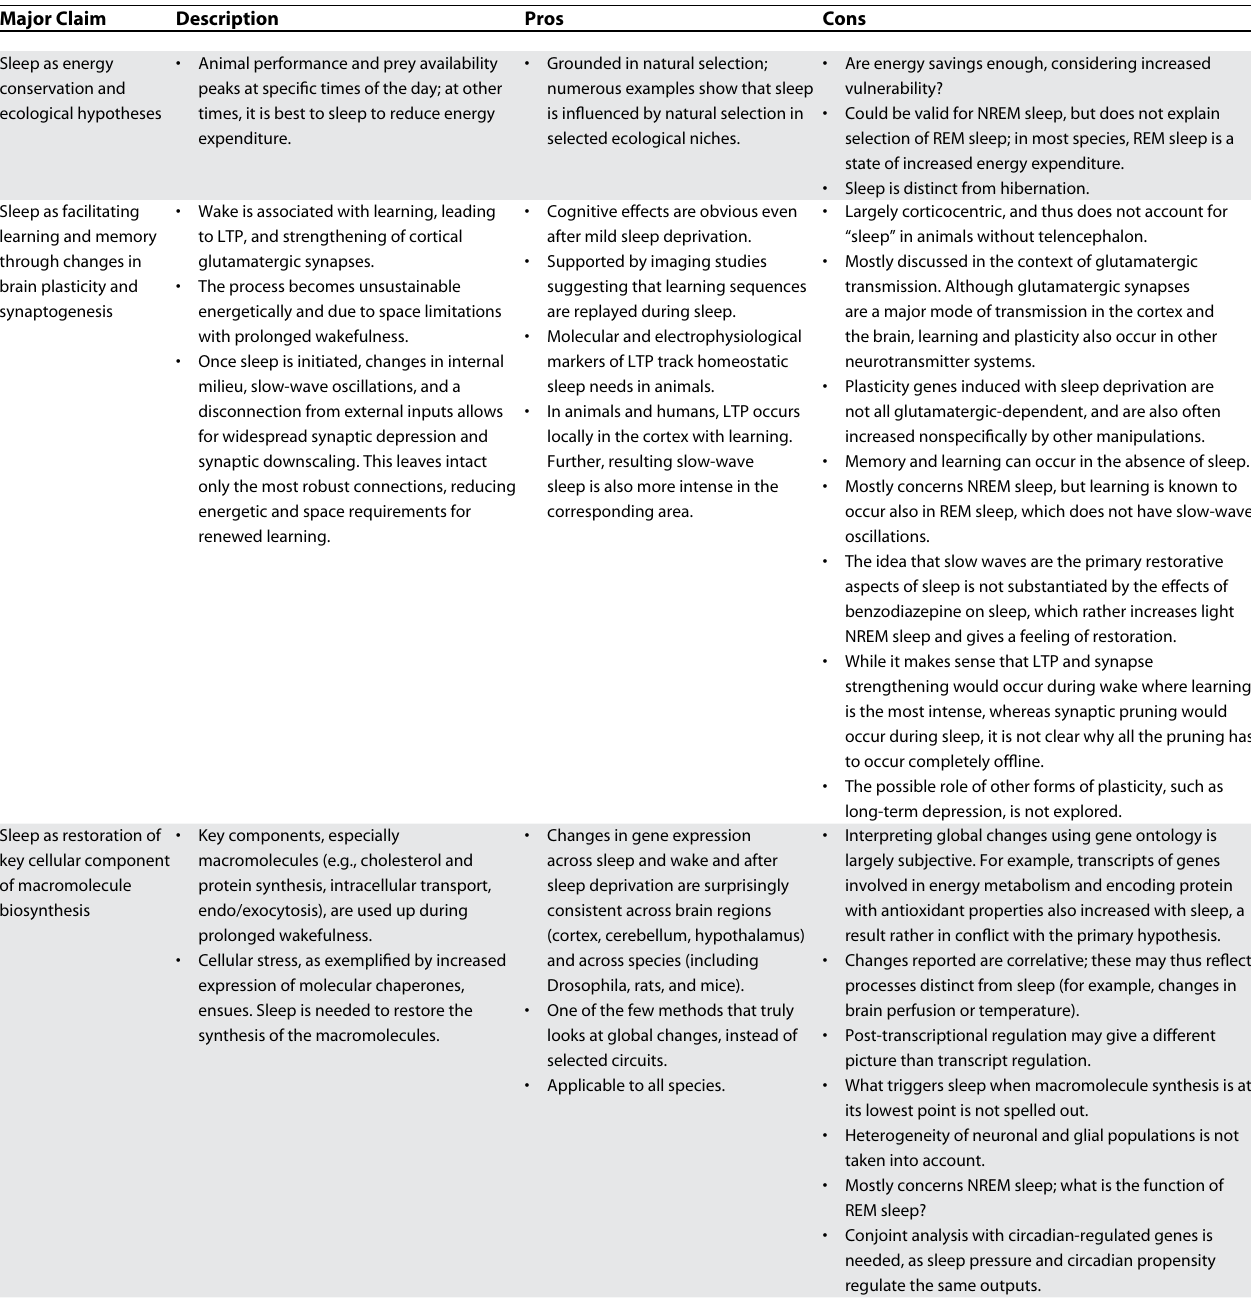
Table 1. Overview of Common Sleep Theories, Including Their Strengths and